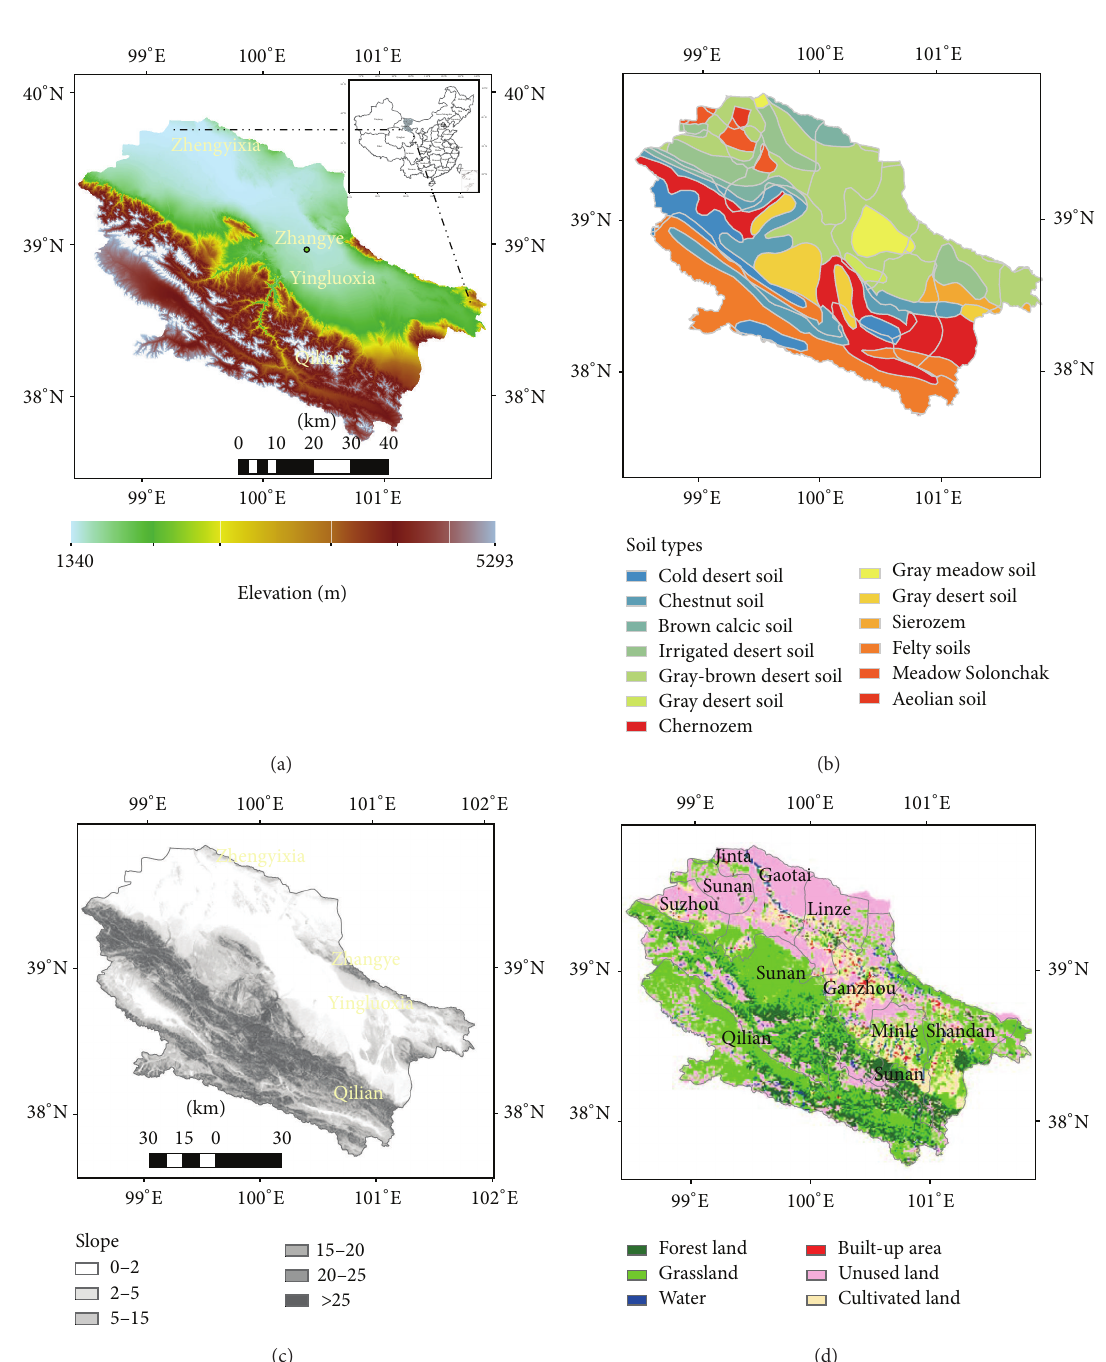
include the river flow data from four hydrological